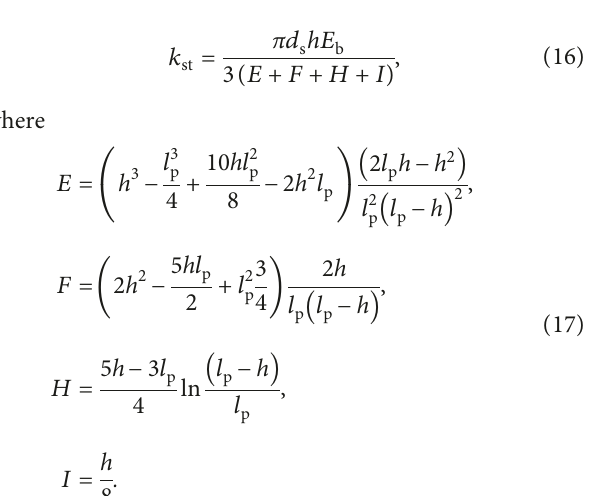
Figure 5: (a) Diagram and (b) enlarged view of the screw-thread structure.